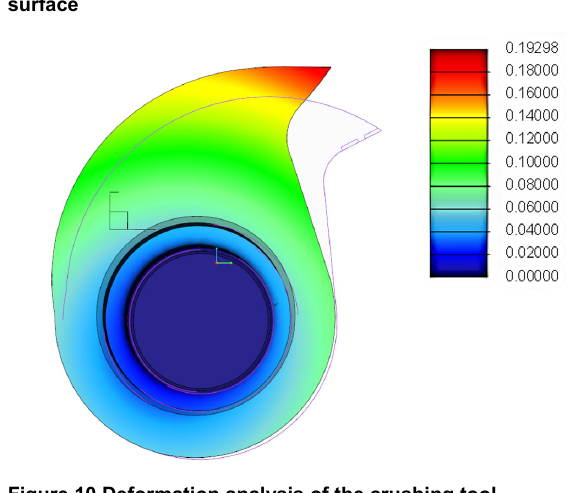
Figure 10 Deformation analysis of the crushing tool